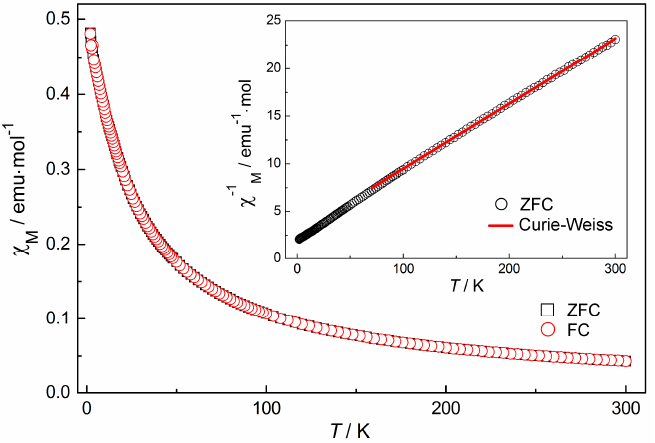
Figure 4. Temperature-dependence of the magnetic susceptibility for as-grown crystal PSO. The inset shows the reciprocal magnetic susceptibility vs. temperature curve. The solid line is the Curie–Weiss fitting.